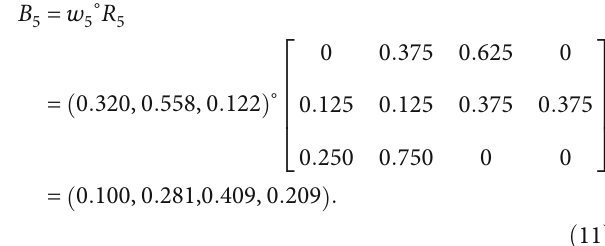
Table 8: Consequence degree index weight (expert E